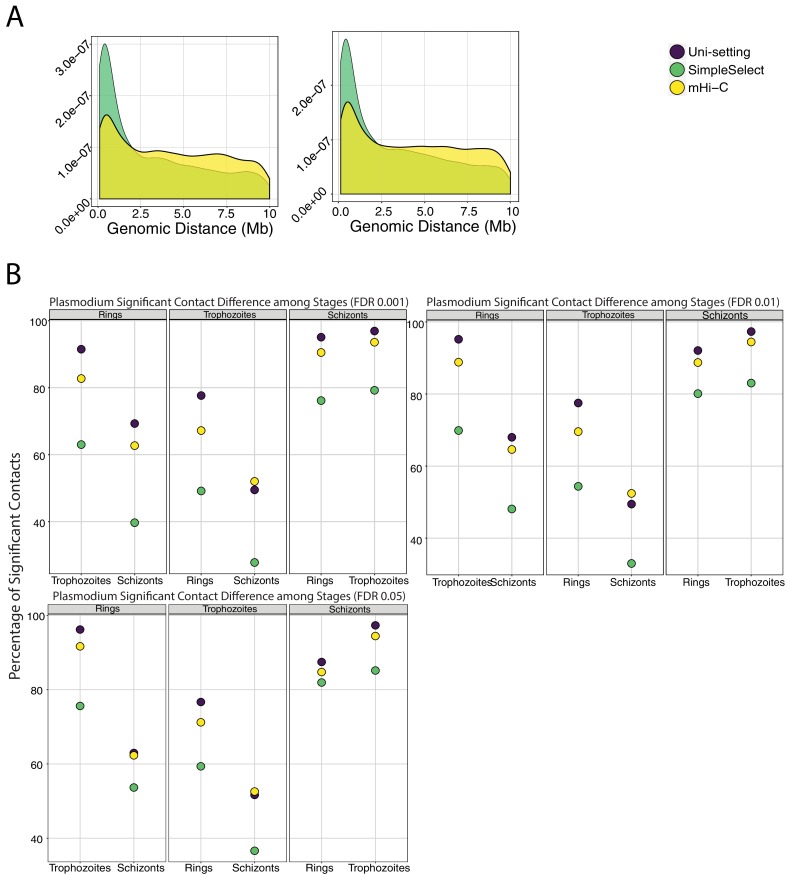
Comparison of significant interactions with respect to genomic distance and life stages between SimpleSelect and mHi-C.(A) Comparison of genomic distance distributions of significant interactions between SimpleSelect and mHi-C for IMR90 rep5 (FDR < 0.001). (B) Comparison of significant interactions among the three life stages of P. falciparum. Y-axis in each panel, namely rings, trophozoites, and schizonts, depicts the percentage of contacts that are significant only in the panel condition compared to the other two conditions. Under varying FDR thresholds, mHi-C and Uni-setting tend to have similar percentages of differential interactions among ring - trophozoites - schizonts plasmodium life stages. In contrast, SimpleSelect tends to underestimate differential interactions due to over-emphasizing contact distance prior.